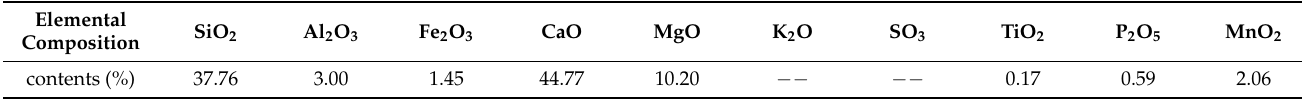
Table 8. Characterization of EAF oxidizing slag.